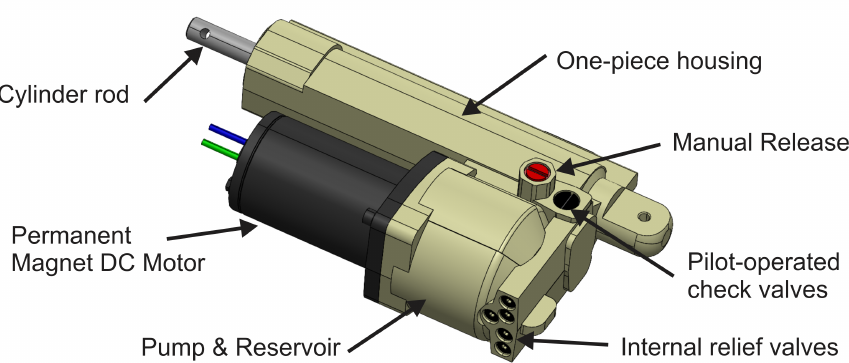
Figure 2. 3D model of C-EHA and main